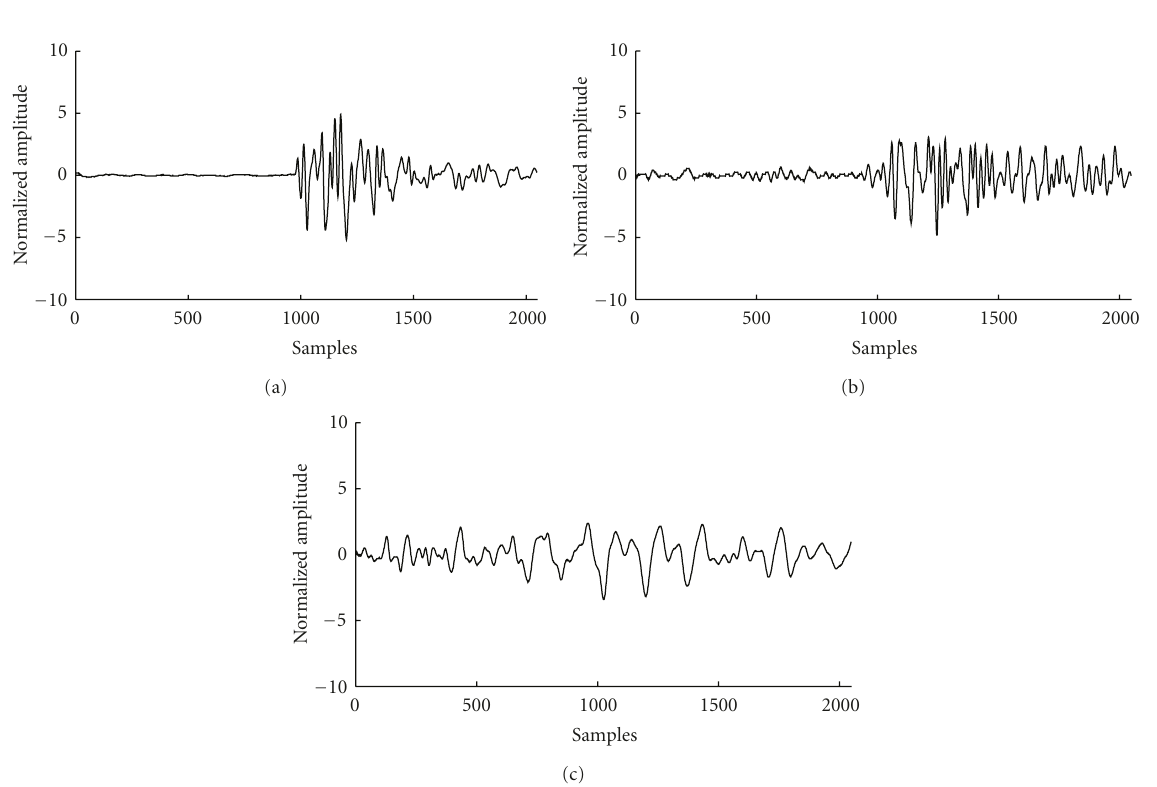
Figure 4: Sample AE recordings. (a) High SNR with clear baseline. (b) Corrupted baseline. (c) Pseudo-AE